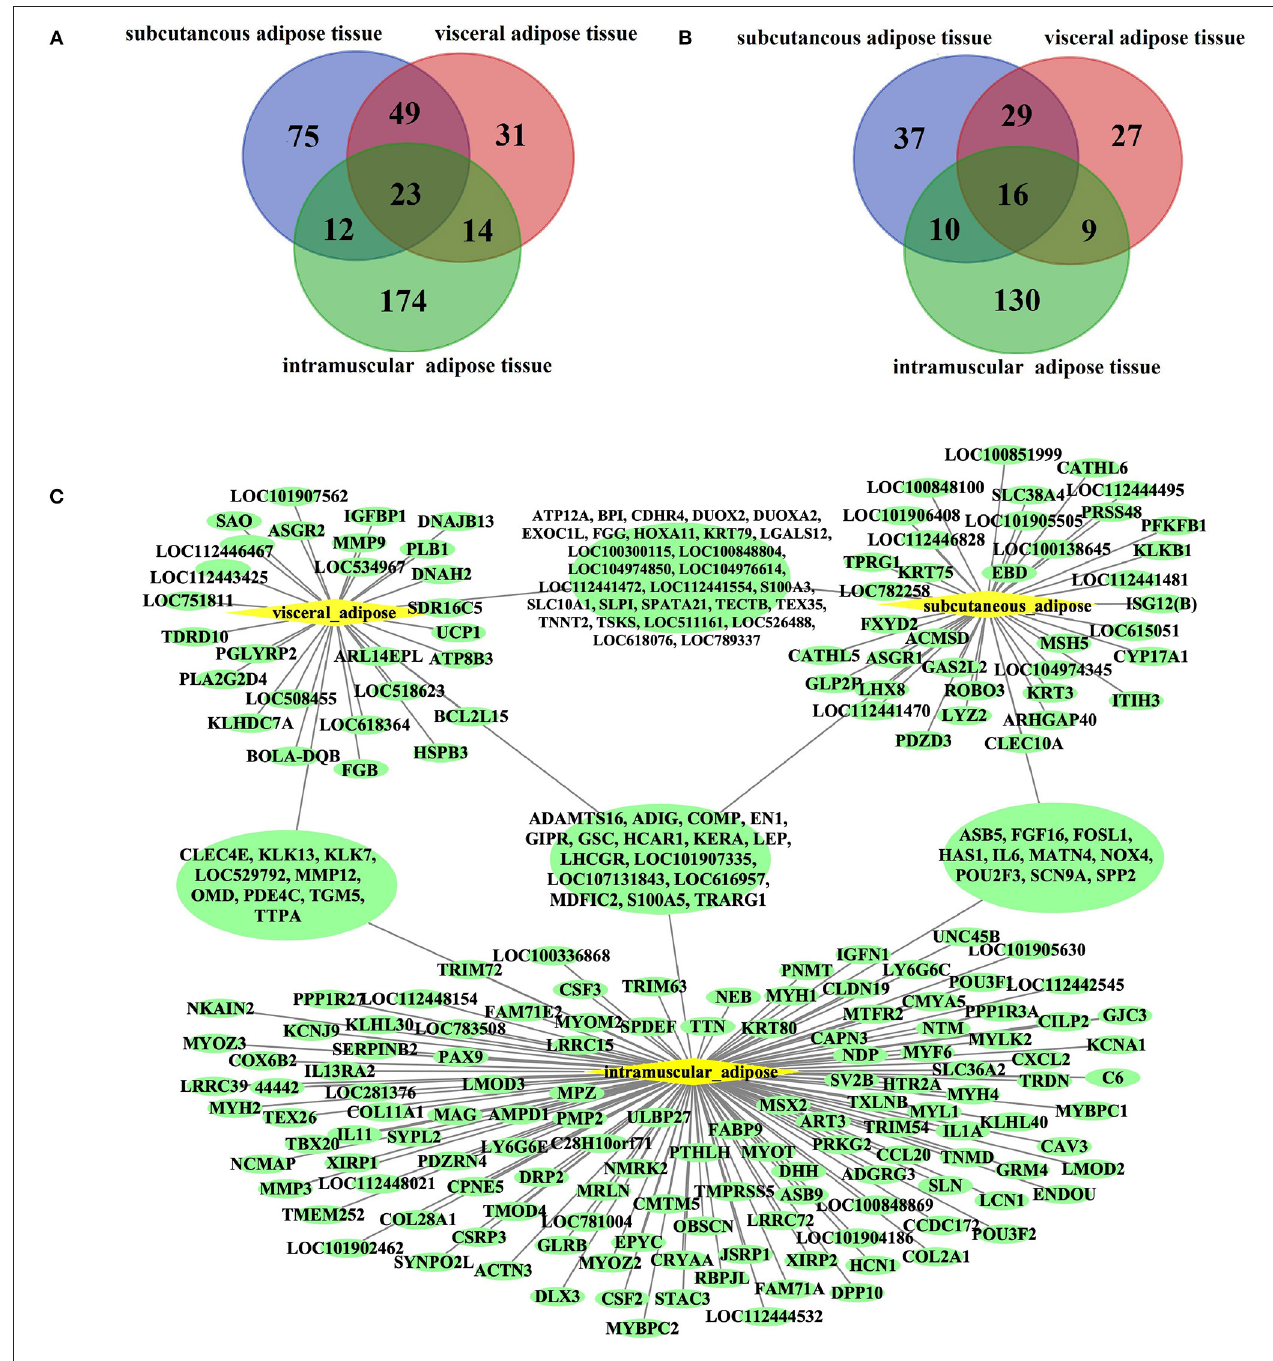
FIGURE 3 | Bovine adipose tissue-specific expressed genes. (A,B) , The venn of adipose tissue-specific genes and protein-coding genes of three kinds of adipose tissues; (C) , tissues specific protein-coding genes of three kinds of adipose tissues.